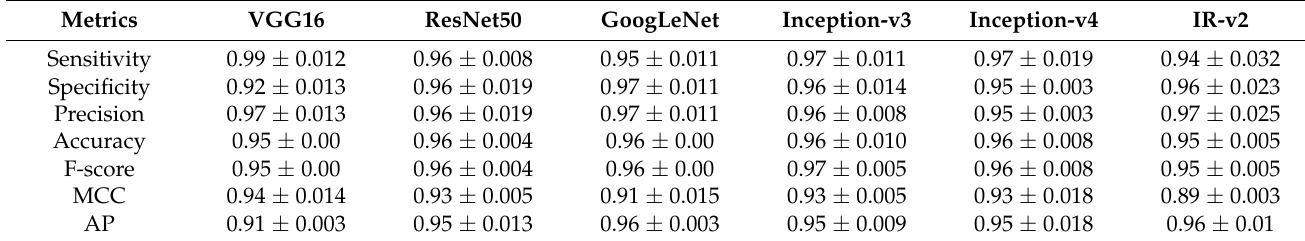
Table 1. Pretrained models with performance metrics along with SD.